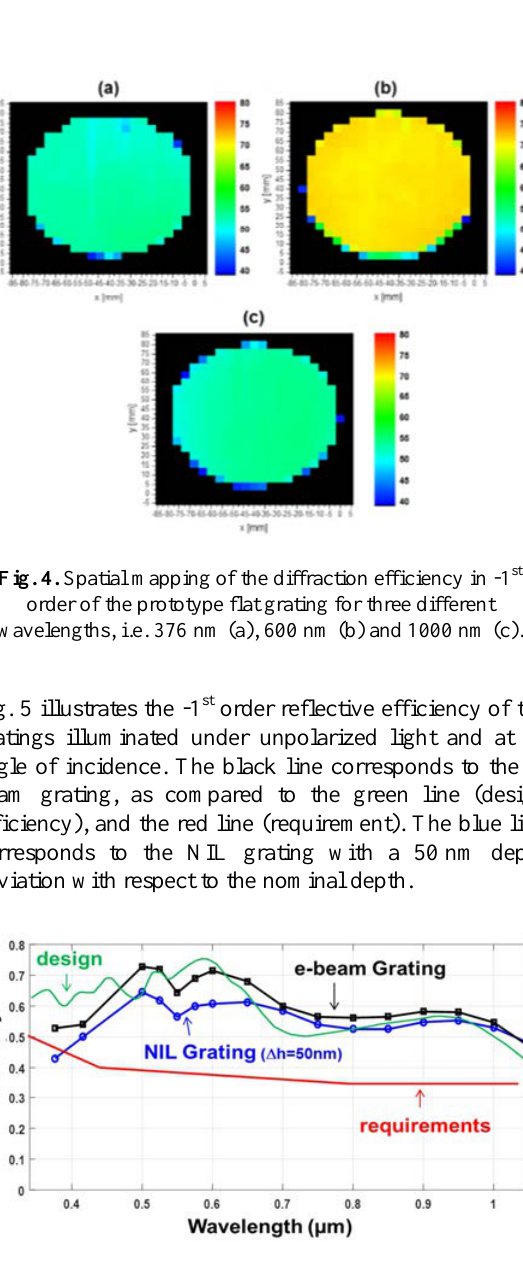
Fig. 5. Measured -1 st order diffraction efficiency of blazed- binary subwavelength gratings.